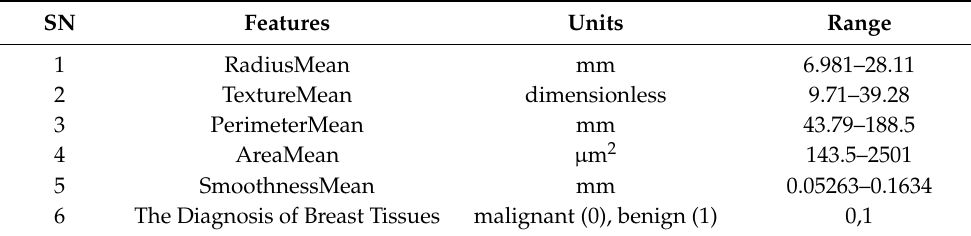
Table 1. Unit and value ranges of the features.